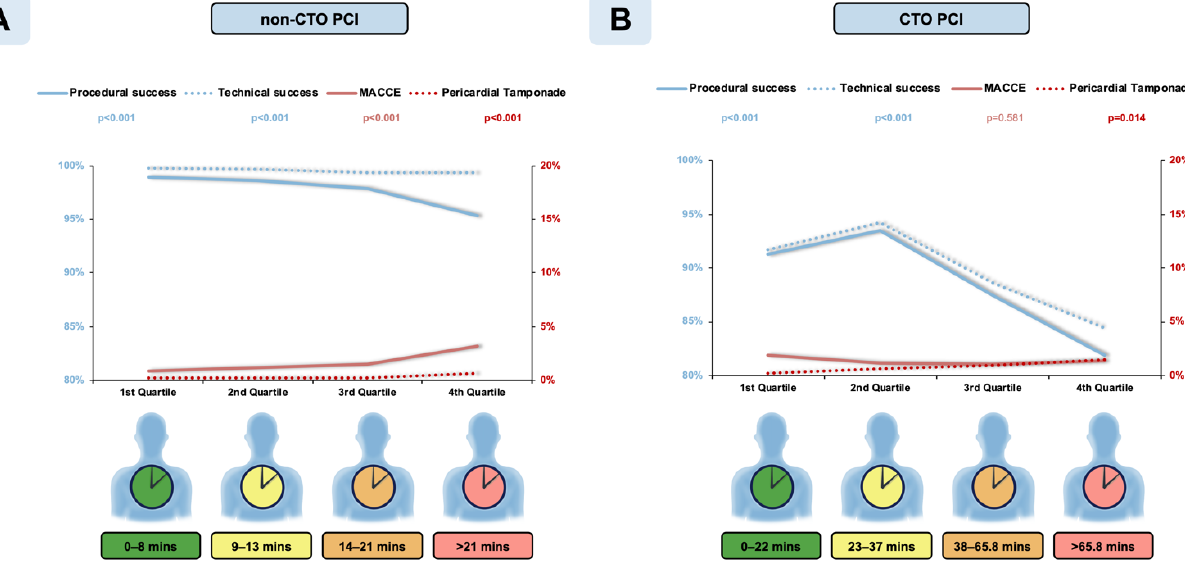
Figure 3. In-hospital outcomes in patients undergoing various length of percutaneous coronary interventions (PCI) targeting nonocclusive (Panel A) and chronic occlusive (Panel B) coronary lesions. CTO, chronic total occlusion, and MACCE, major adverse cardiac and cerebrovascular event.